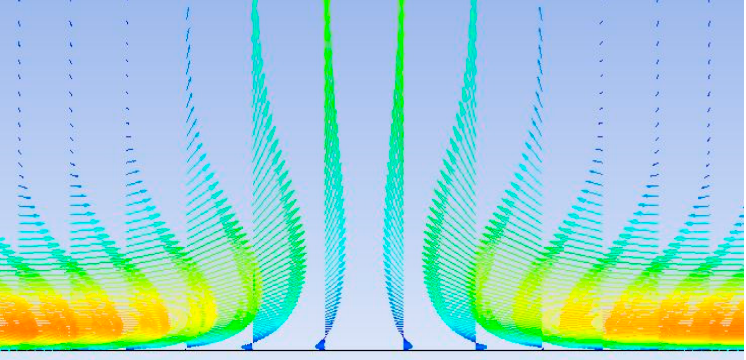
Figure 13. Velocity vector focus on the meeting zone between two wall jets.